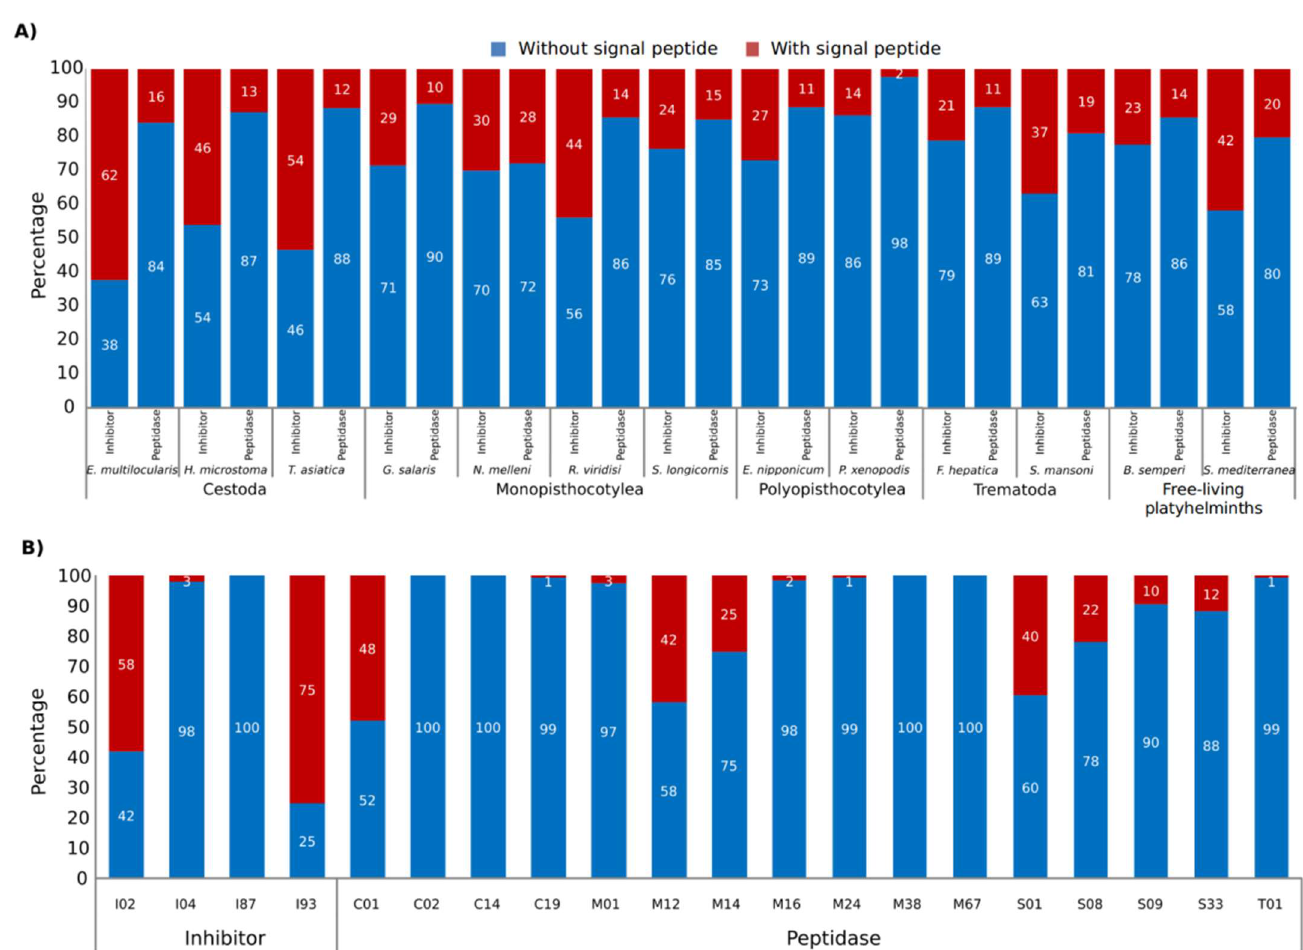
Figure 2. Heat map showing the proportion of peptidase and inhibitor families in each platyhel- minth species.